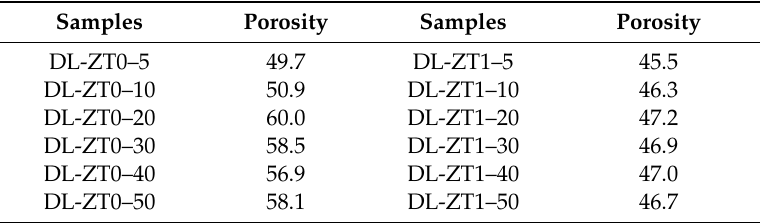
Table 2. Results of porosity for DL-ZT0 and DL-ZT1 at di ff erent air gaps. Samples